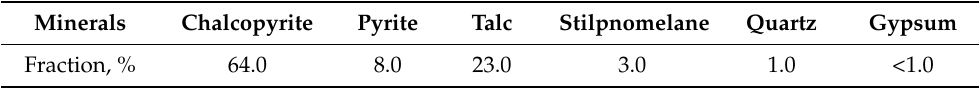
Table 1. Mineralogy composition of chalcopyrite specimen.